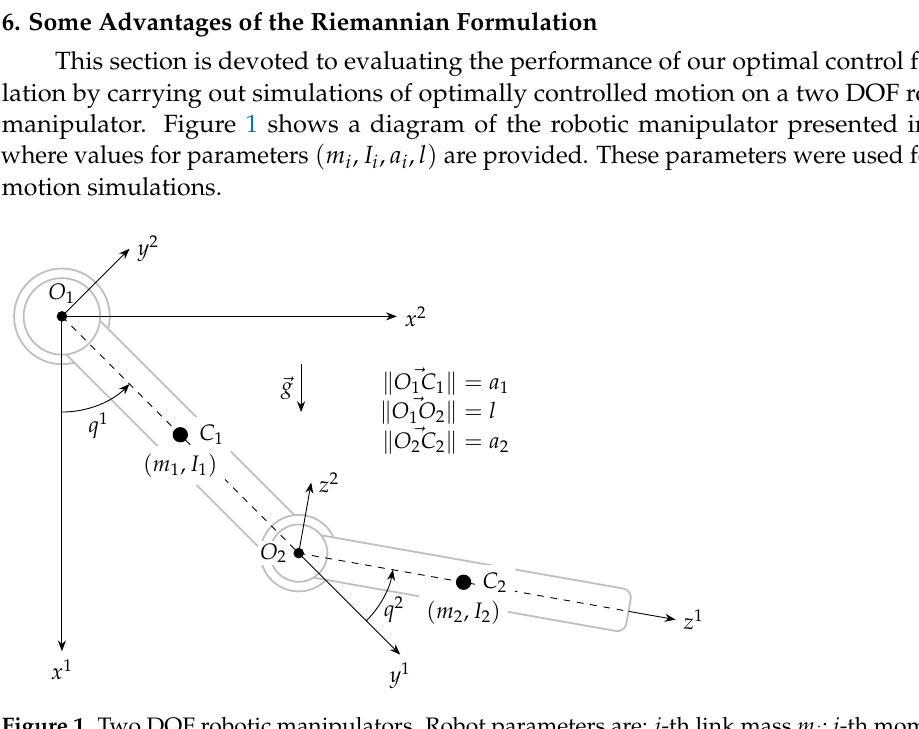
Figure 1. Two DOF robotic manipulators. Robot parameters are: i -th link mass m i ; i -th moment of inertia I i ; distance from joint to center of mass of the i -th link a i ; first link length l ; states q i ( i -th link configuration parameter). Vector (cid:126) g represents the direction of gravity